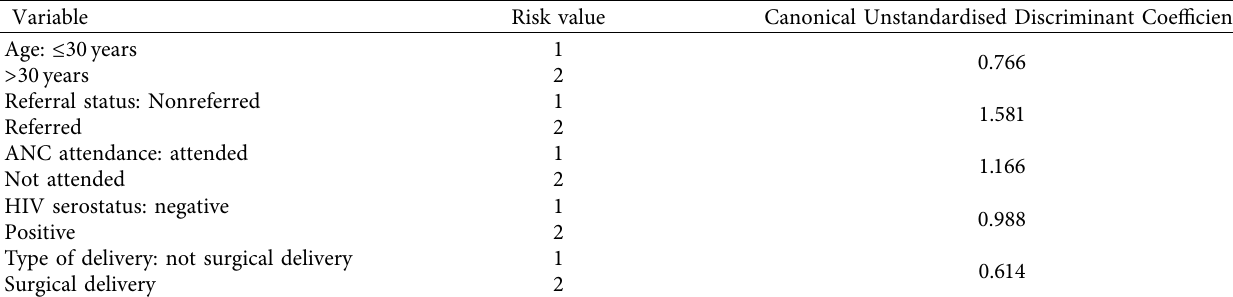
Table 5: Variables, risk values, and Canonical Unstandardised Discriminant Coefficients.